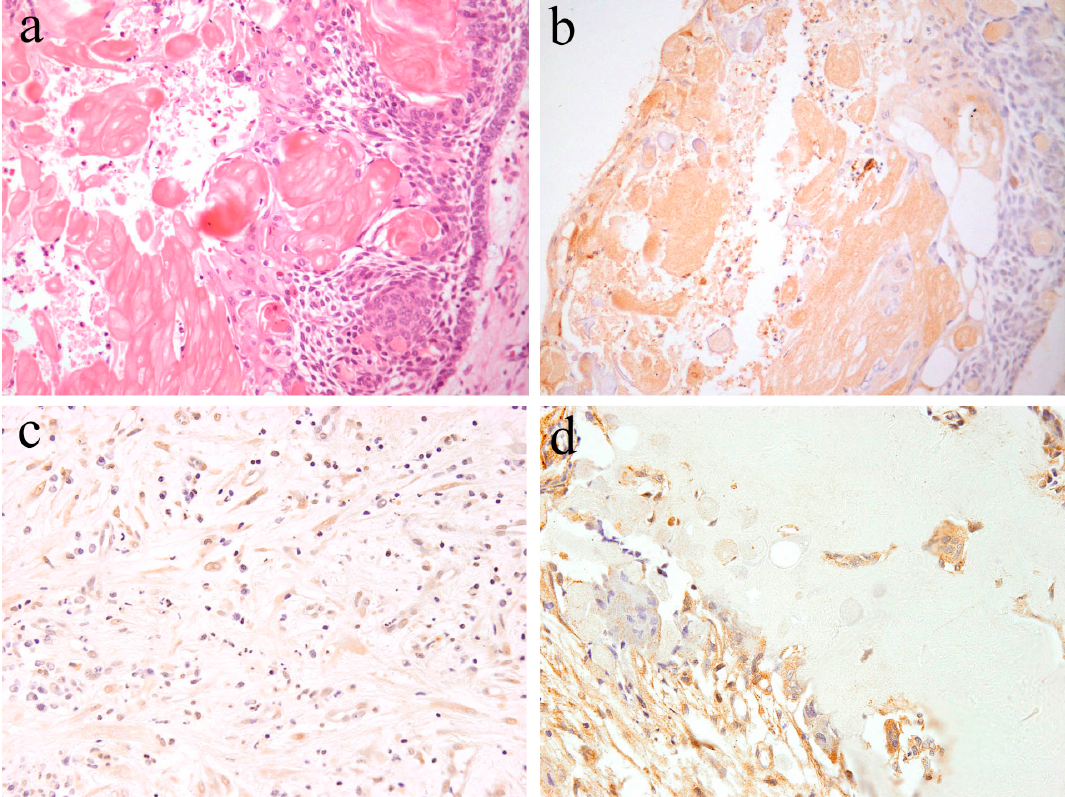
Figure 5. Microscopic features of ( a ) calcifying odontogenic cysts. HE staining, Magnification × 100. ( b ) Notch1-positive reactions are observed in both ghost cells and epithelial cells. Immunohistochemical staining, Magnification × 100. ( c ) Notch1-positive reactions are observed in ectomesenchymal spindle cells. Immunohistochemical staining, Magnification × 100. ( d ) Notch1-positive reactions are observed adjacent to dentinoid tissues. Immunohistochemical staining, Magnification × 100. Anti-Notch-1 intracellular domain antibody, Abcam, ab83232,